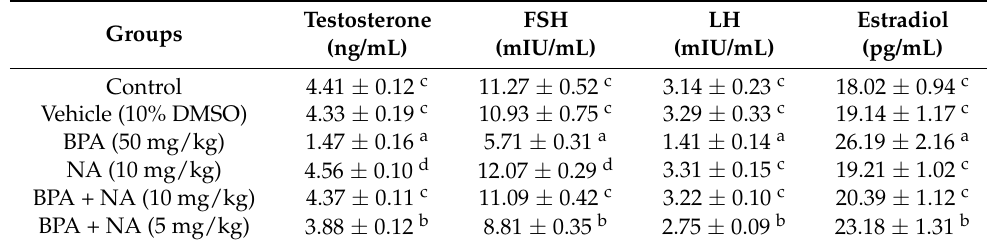
Table 4. Appraisal of reforms to hormonal levels by NA.